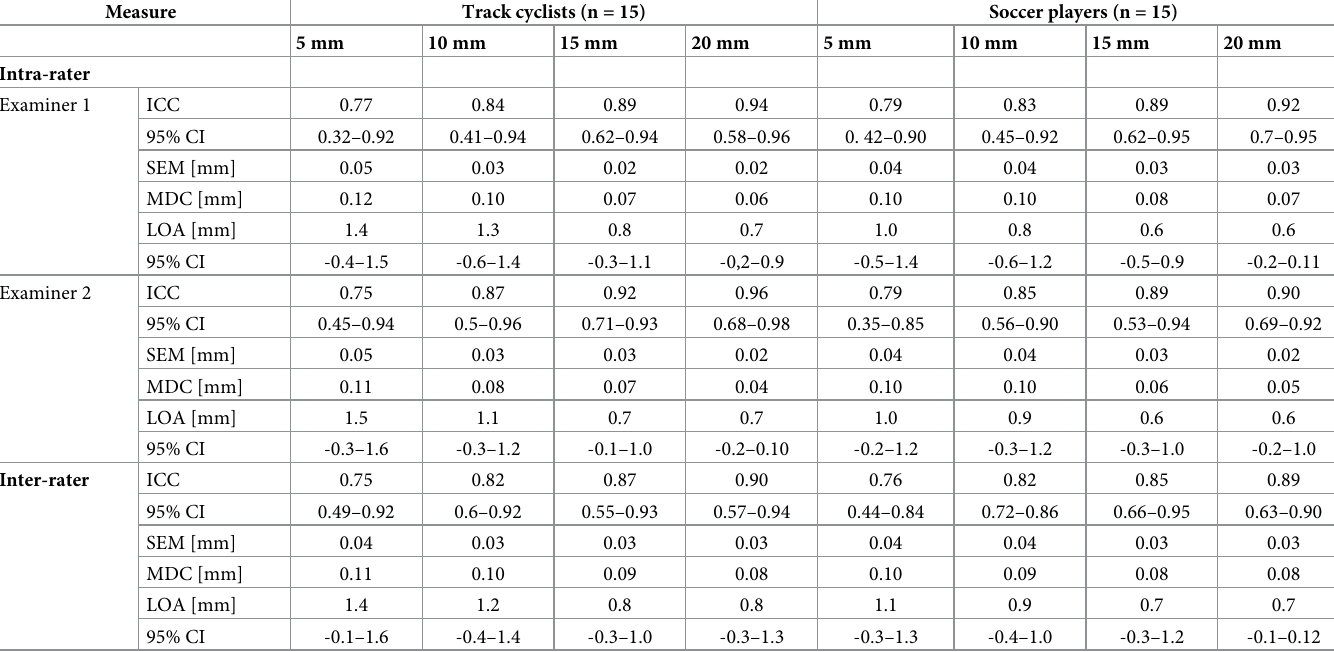
Table 2. Intra-class correlation coefficients (ICC), 95% confidence Interval (95% CI), standard error of measurement (SEM), minimal detectable change (MDC) and 95% limit of agreement (LOA) for intra- and inter-rater reliability of patellar tendon thickness.